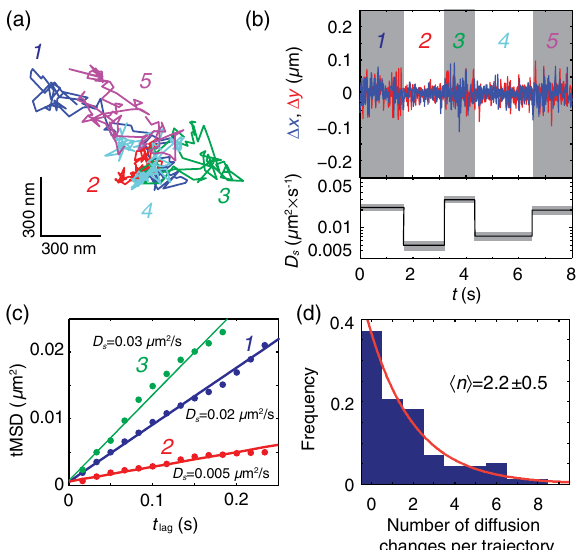
FIG. 3. DC-SIGN motion experiences changes in diffusivity. (a) Representative WT DC-SIGN trajectory displaying changes of diffusivity. Change-point analysis evidences five different regions represented with different colors. (b) Plot of the x (blue) and y (red) displacements for the trajectory in (a) as a function of time. The shaded areas indicate the regions of different diffu- sivity. The lower panel displays the corresponding short-time diffusion coefficient as obtained from a linear fit of the time- averaged MSD for the five different regions. Gray areas corre- spond to the 95% confidence level. (c) Plot of time-averaged MSD versus time lag for the first three regions of the trajectory in (a). (d) Histogram of the number of changes of diffusion per trajectory. Most of the trajectories (63%) display at least one dynamical change, with an average of 2.2 changes per